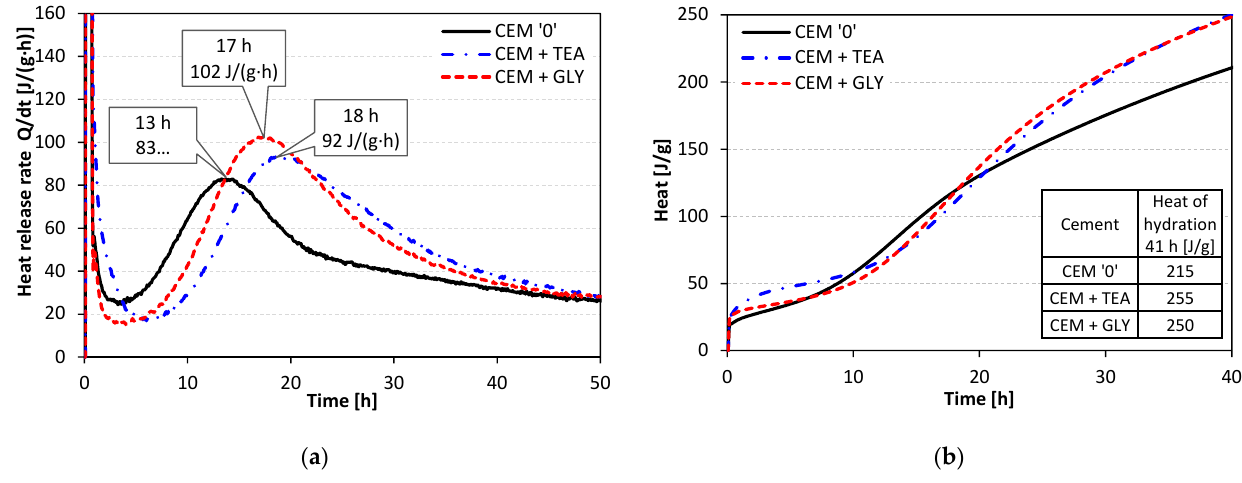
Figure 4. Heat evolution curves of cements: ( a ) heat release rate, ( b ) cumulative heat.